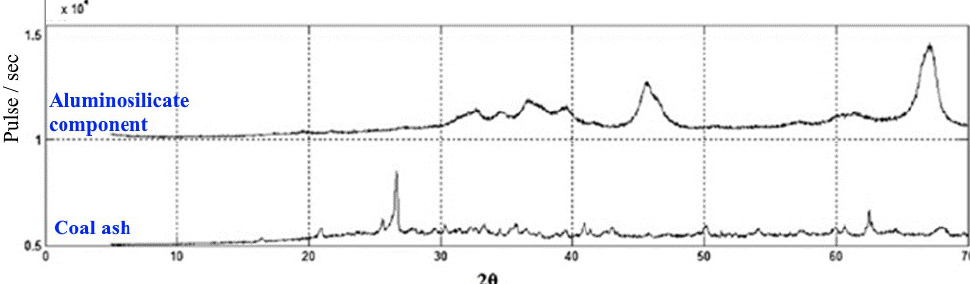
Figure 18. Comparison of XRD spectra of initial coal ash and aluminosilicate component. The developed aluminosilicate component, in terms of its granulometry, chemical, and mineral composition has significant potential for use as an active additive in a com- posite binder. In particular, the compressive strength for 7- and 28-day samples, when Portland cement is replaced by 15% with an aluminosilicate additive, increases to 30 – 35% (Figure 19).